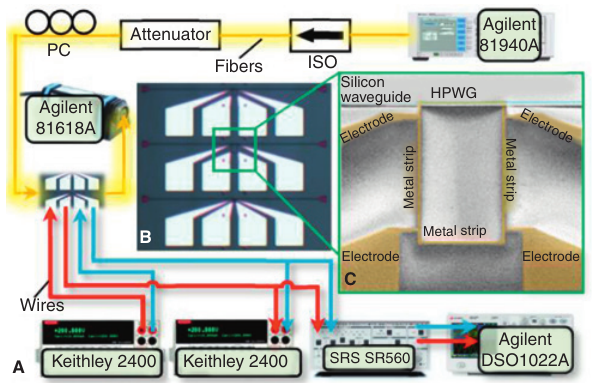
Figure 3: Measurement setup. (A) Test set-up to characterize the responsivity, dynamic range, and response speed of the fabricated optical power monitor. (B) Microscope graph of the fabricated power monitor along with focused grating couplers and metal pads for testing. (C) SEM picture of the fabricated optical power monitor integrated with a Wheatstone bridge